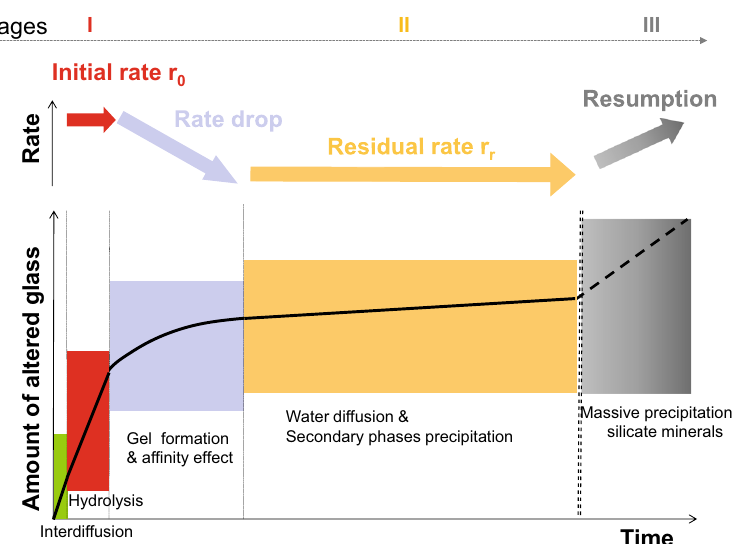
Fig. 1 Stages of nuclear glass corrosion. (Reproduced with permission from ref. 6 , copyright Elsevier